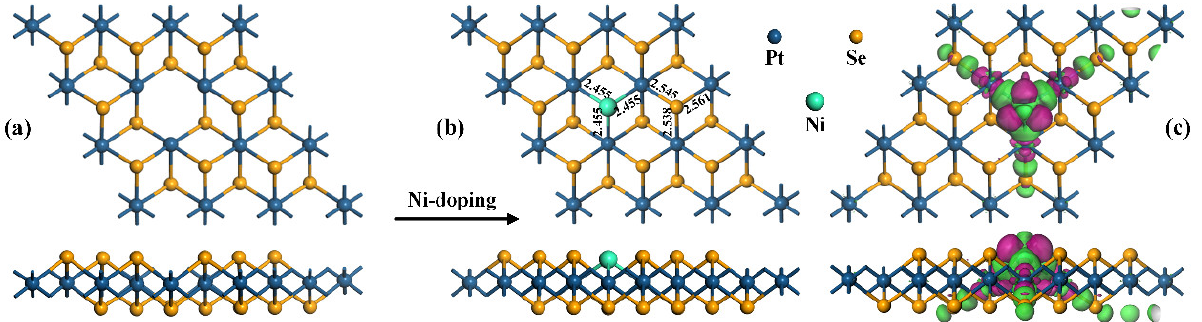
Figure 2. Ni doping process on the PtSe 2 monolayer with Se-vacancy. The MSC of ( a ) the PtSe 2 monolayer with Se-vacancy: ( b ) Ni-PtSe 2 monolayer; and ( c ) related EDD of Ni-PtSe 2 monolayer. In EDD, the green (rosy) areas indicate electron accumulation (depletion).